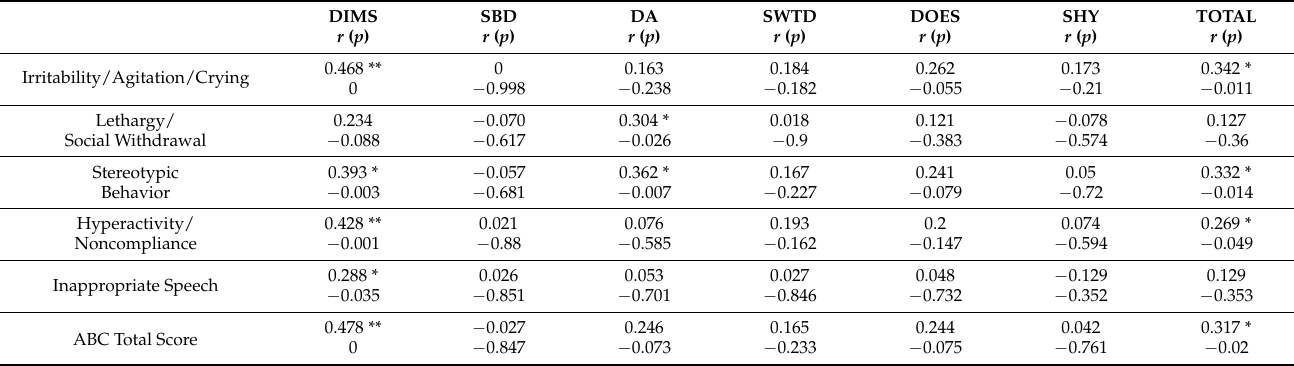
Table 3. Association between sleep disturbances and behavioral problems. * p < 0.05; ** Survived to Bonferroni correction p ≤